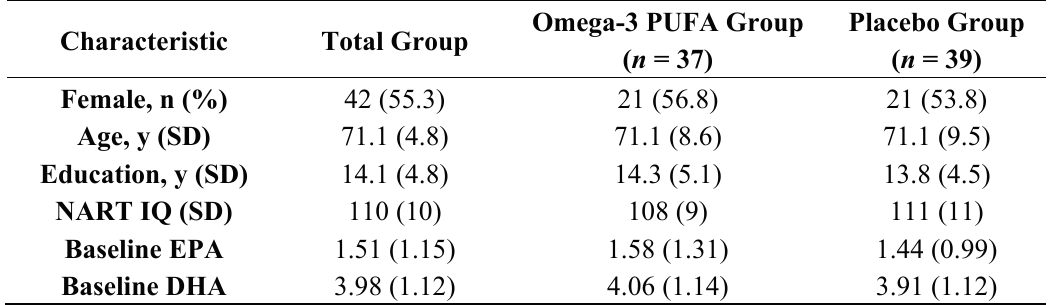
Table 1. Characteristics of participants in the omega-3 fatty acid and placebo groups at study